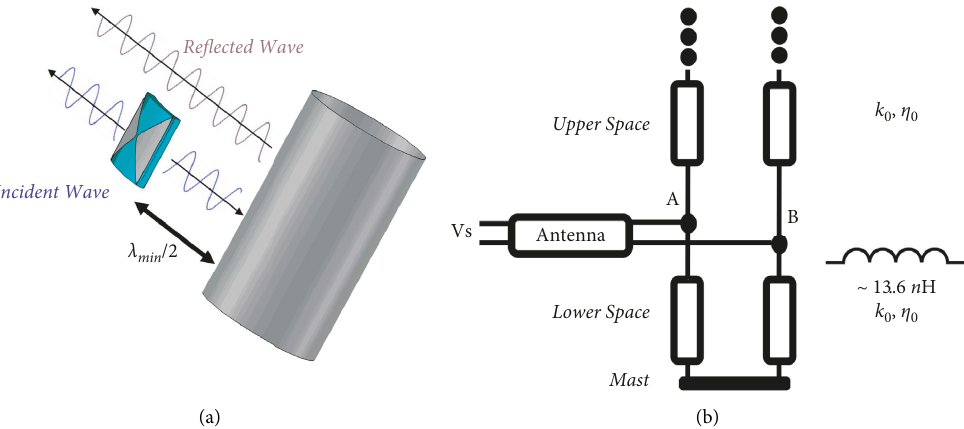
Figure 4: (a) CAD model of a single bow-tie antenna with metal mast and (b) transmission-line equivalent